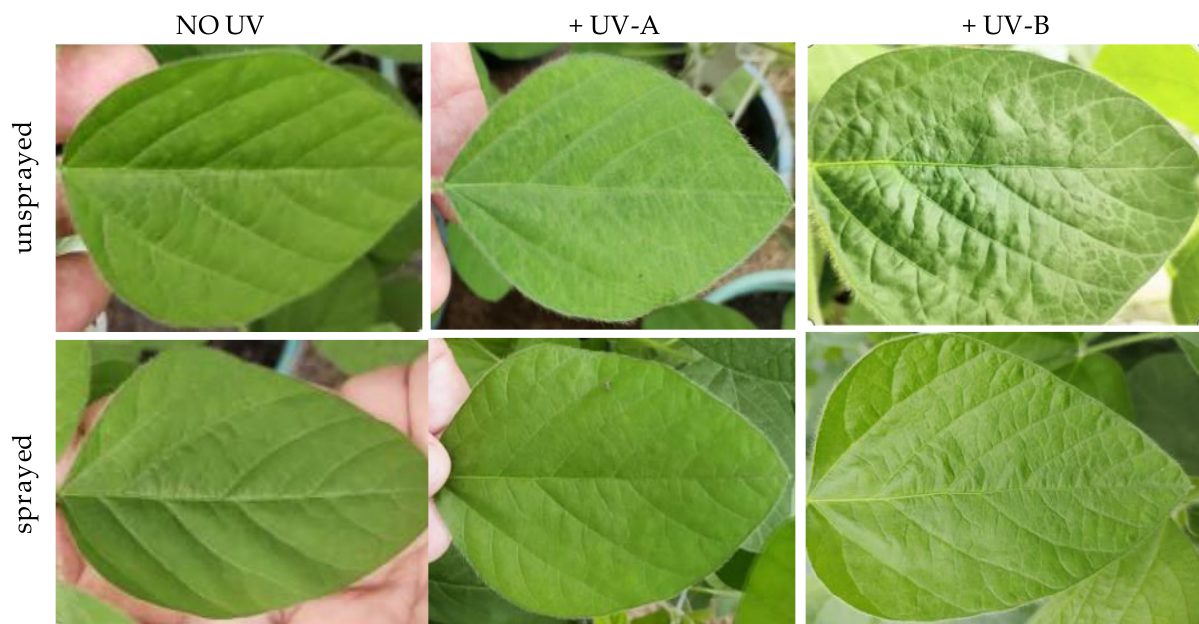
Figure 5. Images of leaflets from trifoliate V4 under trial treatments. The size of each leaflet is out of comparable scale and shown for symptoms illustration.